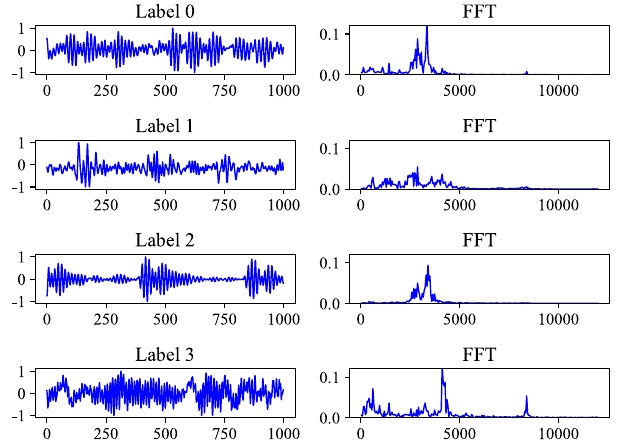
Figure 2. Vibration signal samples of different fault type and their FFT